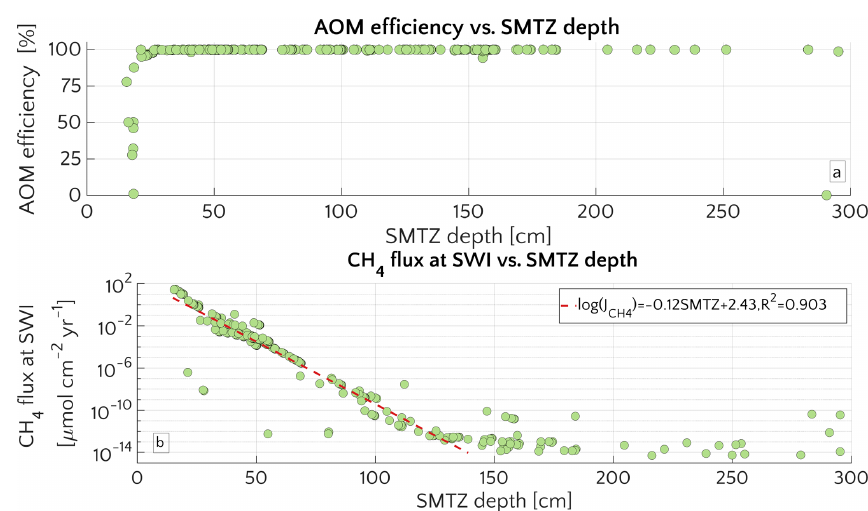
Figure 2. Aggregation of all the simulation performed for the “one-at-time” sensitivity study. (a) AOM efficiency versus the depth of the SMTZ. (b) Scatter plot and semi-log fit of the methane flux ( J CH